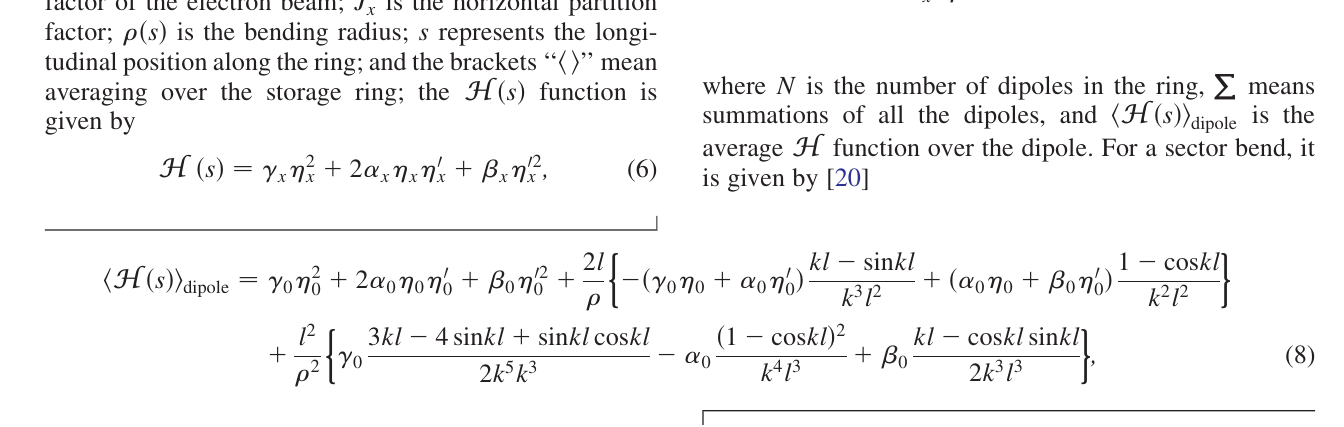
and (cid:5) 0 . 0 0 ; (cid:5) 0 Þ 0 0